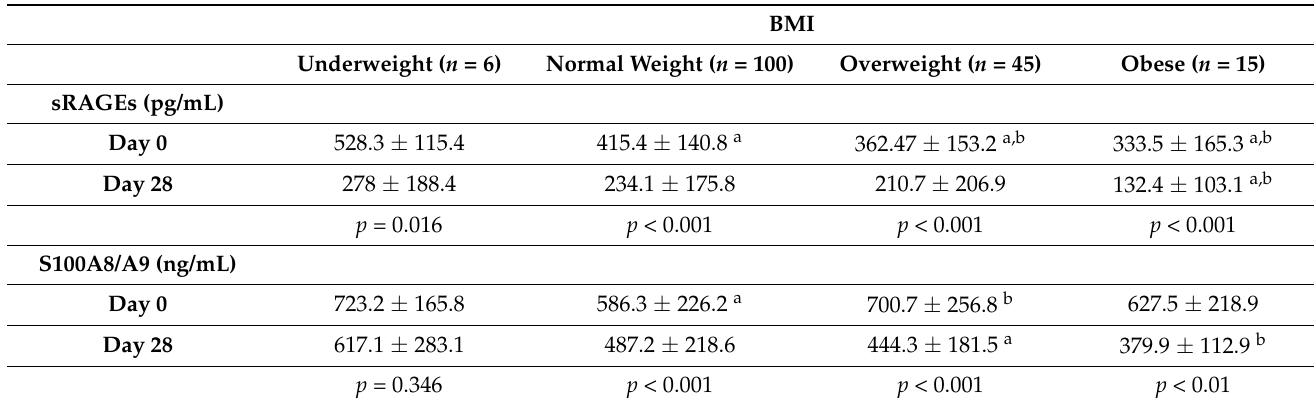
Table 3. Biomarkers’ levels before and after exercise across BMI categories.